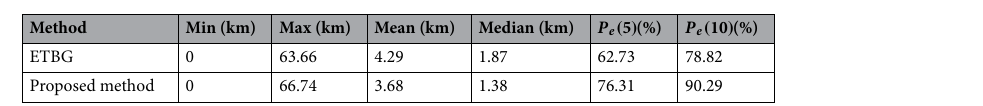
Table 5. Geolocation error estimation capability